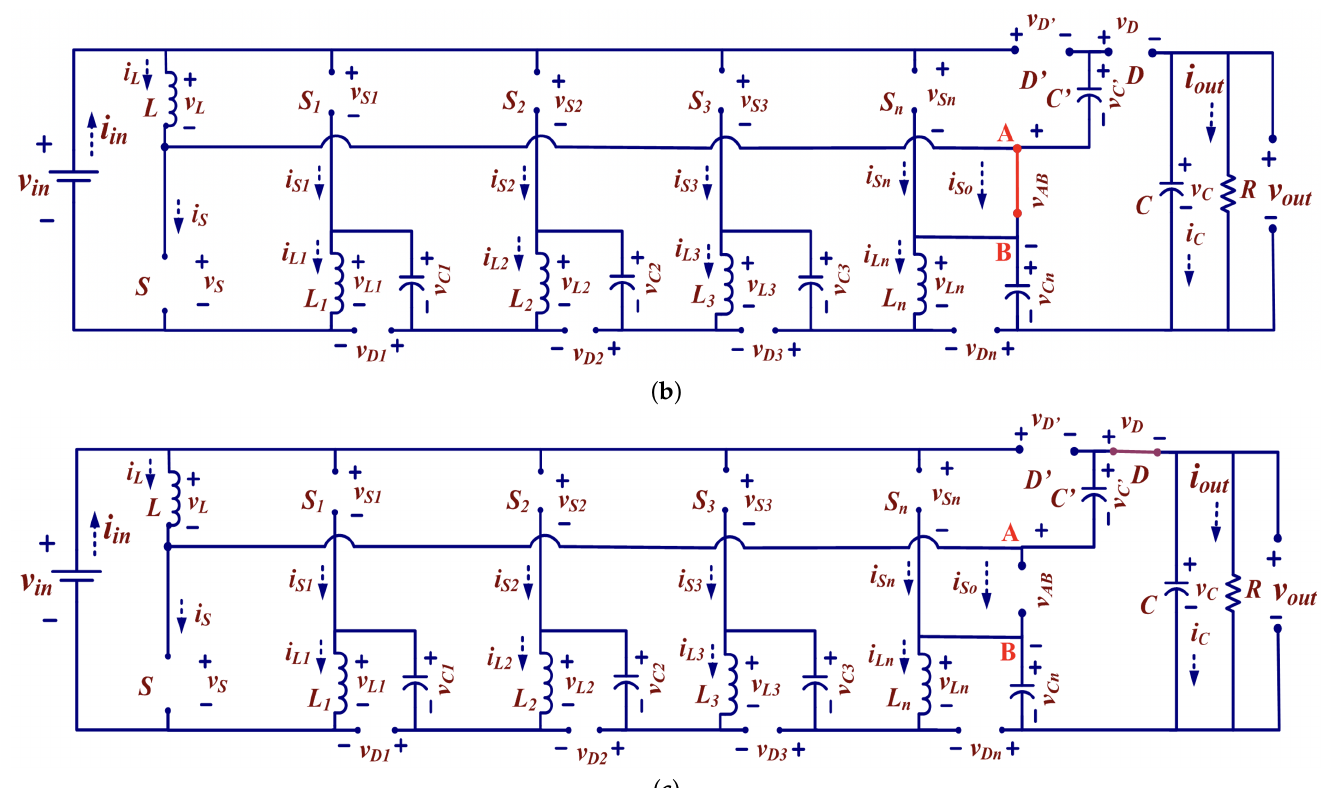
Figure 4. Operating modes, ( a ) mode-I, ( b ) mode-II, and ( c )